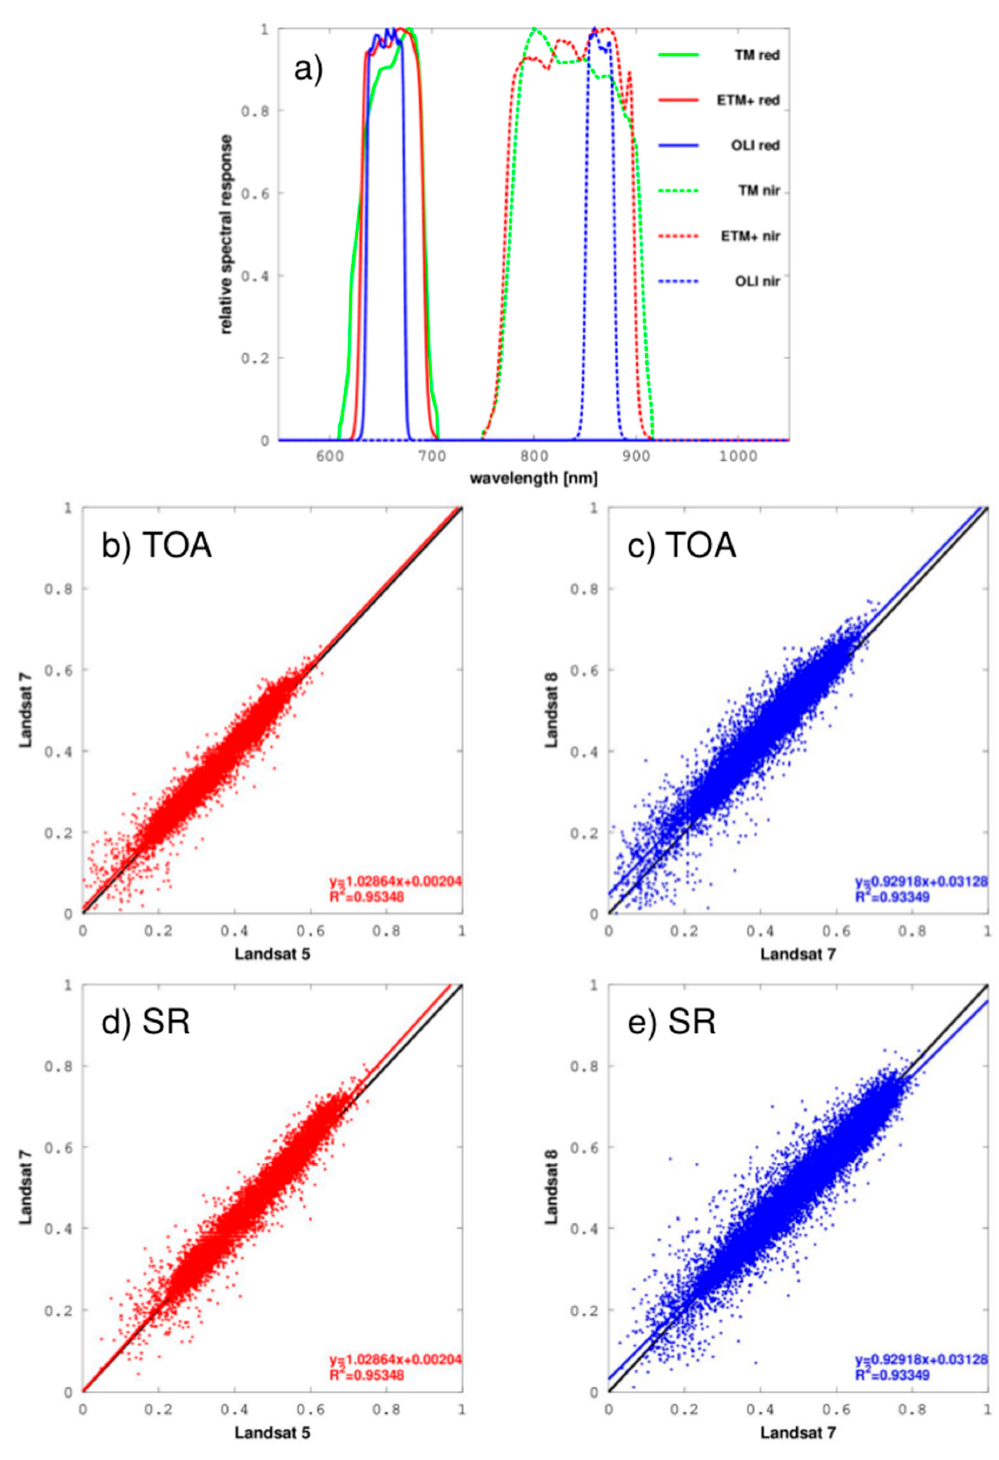
Figure 2. ( a ) Relative spectral response (RSR) of Landsat Thematic Mapper (TM), Enhanced Thematic Mapper (ETM+), and Operational Land Imager (OLI) sensors for the corresponding reflectance bands used in this study. Linear relationships between ( b ) top of atmosphere (TOA) normalized difference vegetation index (NDVI) Landsat 5 TM and 7 ETM+; ( c ) TOA NDVI Landsat 7 ETM+ and 8 OLI; ( d ) surface reflectance (SR) NDVI Landsat 5 TM and 7 ETM+; ( e ) SR NDVI Landsat 7 ETM+ and 8 OLI. The regression equation and determination coefficient (R 2 ) are shown. The black lines show a 1:1 relationship and the red and blue lines are the linear regression lines of best fit for TOA and SR data,